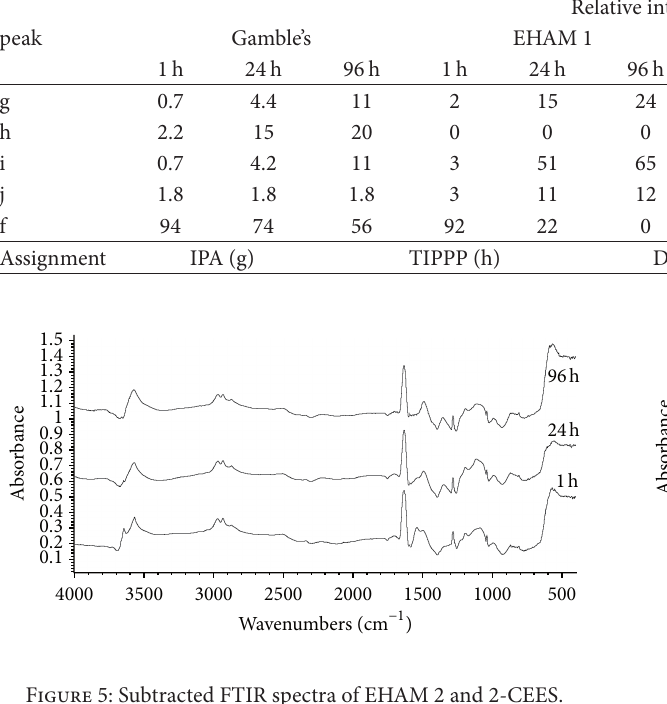
F 5: Subtracted FTIR spectra of EHAM 2 and 2-CEES. F 6: Subtracted FTIR spectra of EHAM 4 and